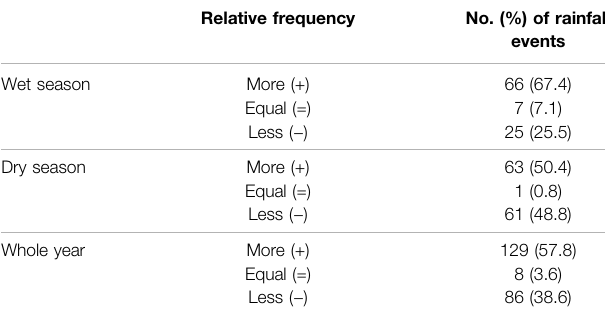
TABLE 1 | Climatological anomalies in rainfall frequency over the seismic